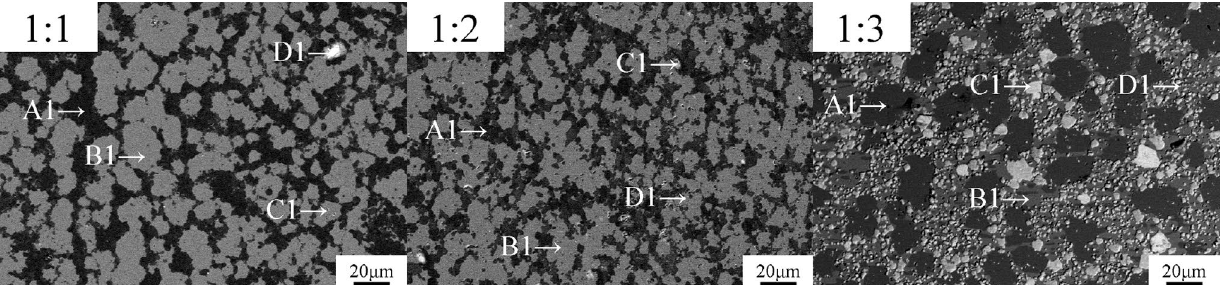
Figure 4. Backscattered electron maps of the sample at various atomic ratios ( a ) 1:1, ( b ) 1:2, ( c ) 1:3.